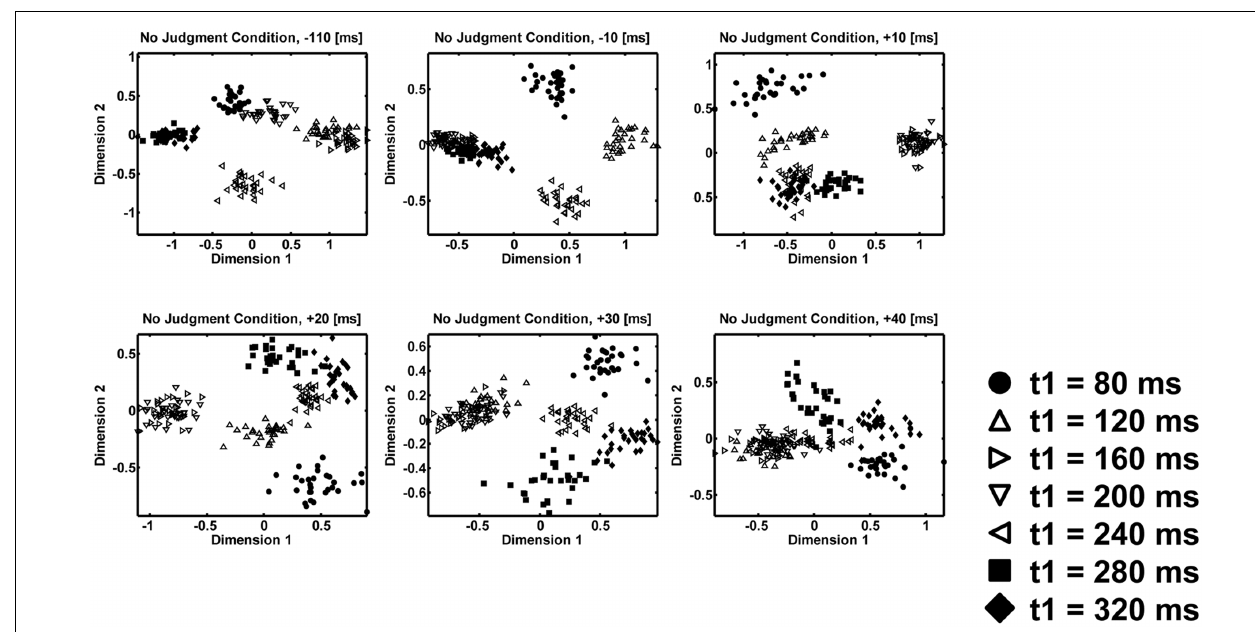
symbols represent perceptually unequal temporal patterns. Open symbols represent perceptually equal temporal patterns.The scatter of a symbol shows the variability across different resampling in bootstrapping ( N =